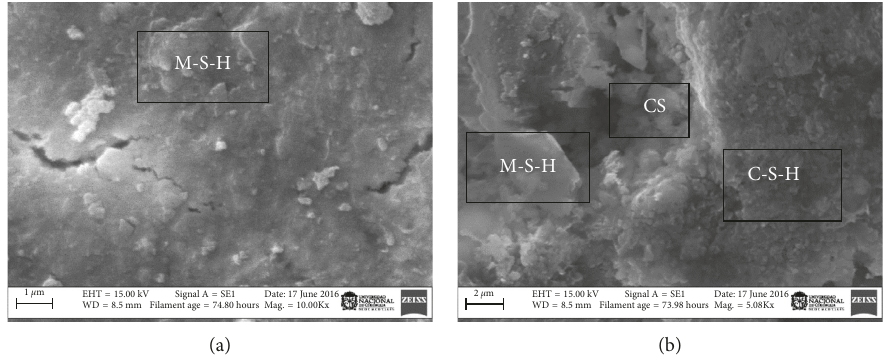
Figure 12: Border to the specimen of (a) PEC5S-0 and (b) PEC5S-10.